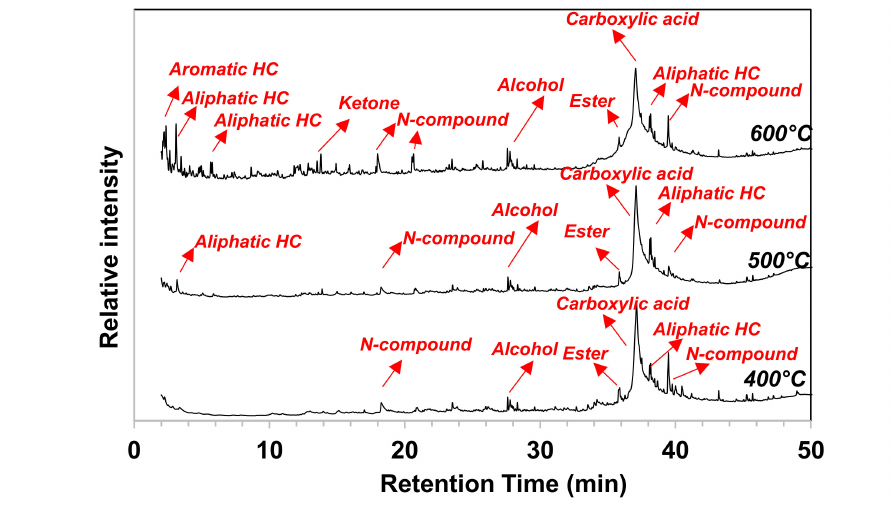
Figure 7. Pyrolysis-GC / MS (Py-GC / MS) chromatograms of Sacha inchi (SI) pyrolyzed products at pyrolysis temperature of 400–600 ◦ C.